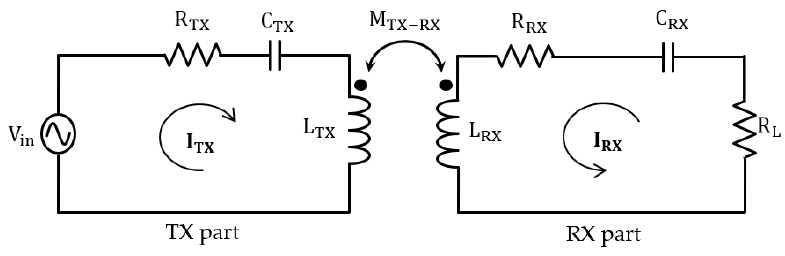
Figure 4. The equivalent circuit of series – series compensation topology of the WPT system.